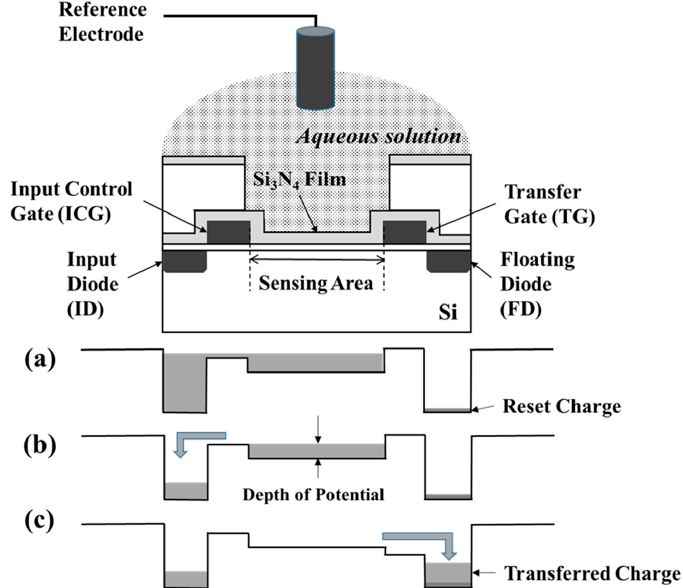
Figure 1. Cross-sectional view of a sensing pixel and measurement principle to focus on charges. ( a ) Charge supply into the depth of potential; ( b ) holding of charges corresponding to the depth; ( c ) transferring of charges to measure. Sensors 2019 , 19 , x FOR PEER REVIEW